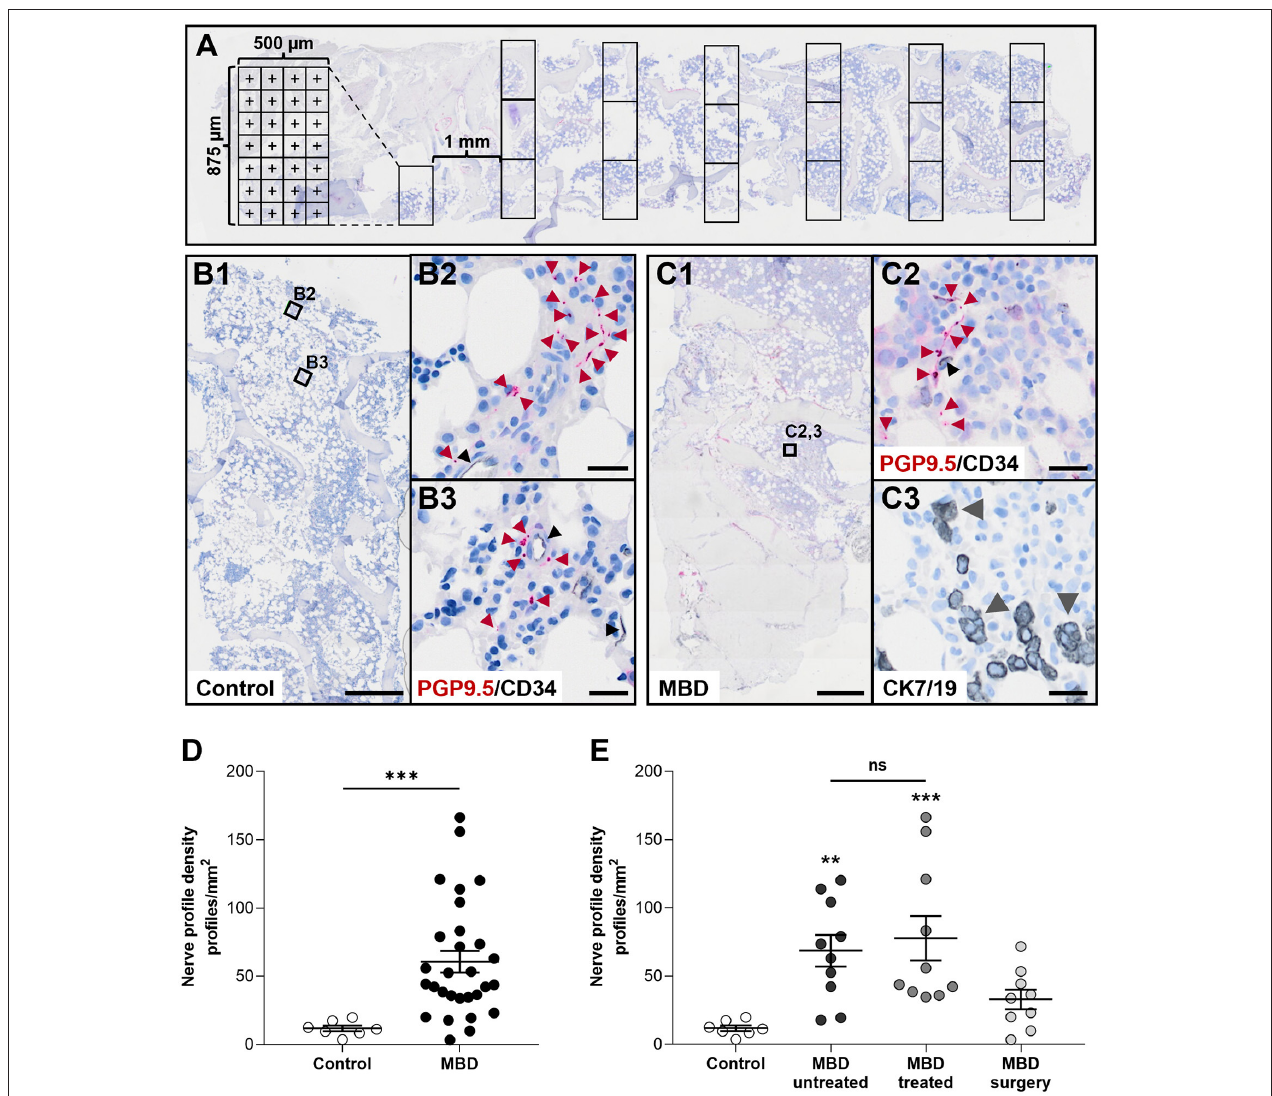
FIGURE 1 | Cancer-infiltrated bone marrow has a significantly increased nerve profile density compared to healthy bone marrow. (A) Illustration of the histomorphometric method used to estimate the area of analysis. (B,C) Overview of sections (B1,C1) and close ups demonstrating the identification of PGP9.5-positive nerve profiles and CD34-positive endothelial cells found in healthy controls (B2,B3) , and in the bone marrow of patients with metastatic bone disease (MBD) (C2) . For patients with MBD the adjacent section was stained for cytokeratin 7 and 19 (CK7/19, gray arrow heads) to identify cancer cells (C3) . (D) The nerve profile density was significantly increased in the cancer-infiltrated bone marrow compared to healthy bone marrow. (E) Subgroups within the cancer-infiltrated biopsies demonstrated a significant increase in nerve profile density in the bone marrow of both the MBD untreated and MBD treated group compared to healthy bone. No difference was found in between the two groups. Comparisons were performed with Mann-Whitney U test or Kruskal–Wallis one-way analysis of variance followed by Dunn’s multiple comparisons test as appropriate. Data are presented as mean ± SEM. ** p < 0.01, *** p < 0.001. Scale bars: B1 and C1, 500 µ m, B2,3 and C2,3 20 µ